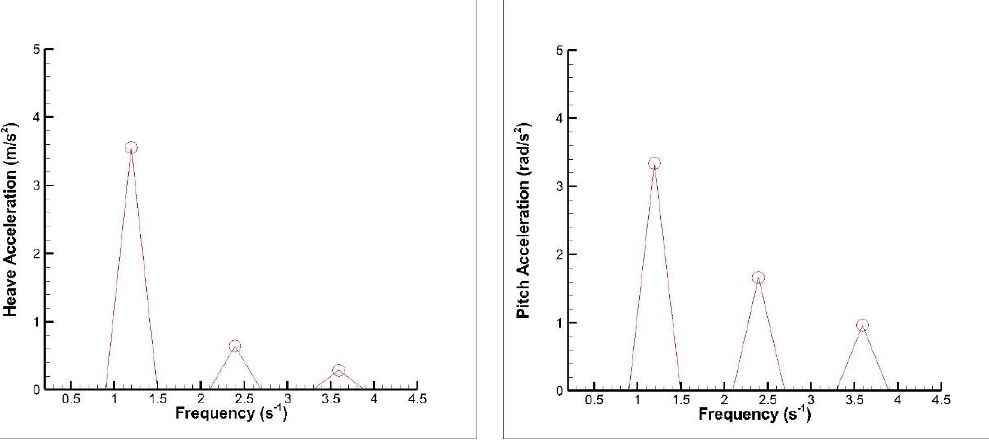
Figure 21. Frequency domain response of heave ( left ) and pitch ( right ) accelerations for C8, Fn B = 2.82, warped hull.